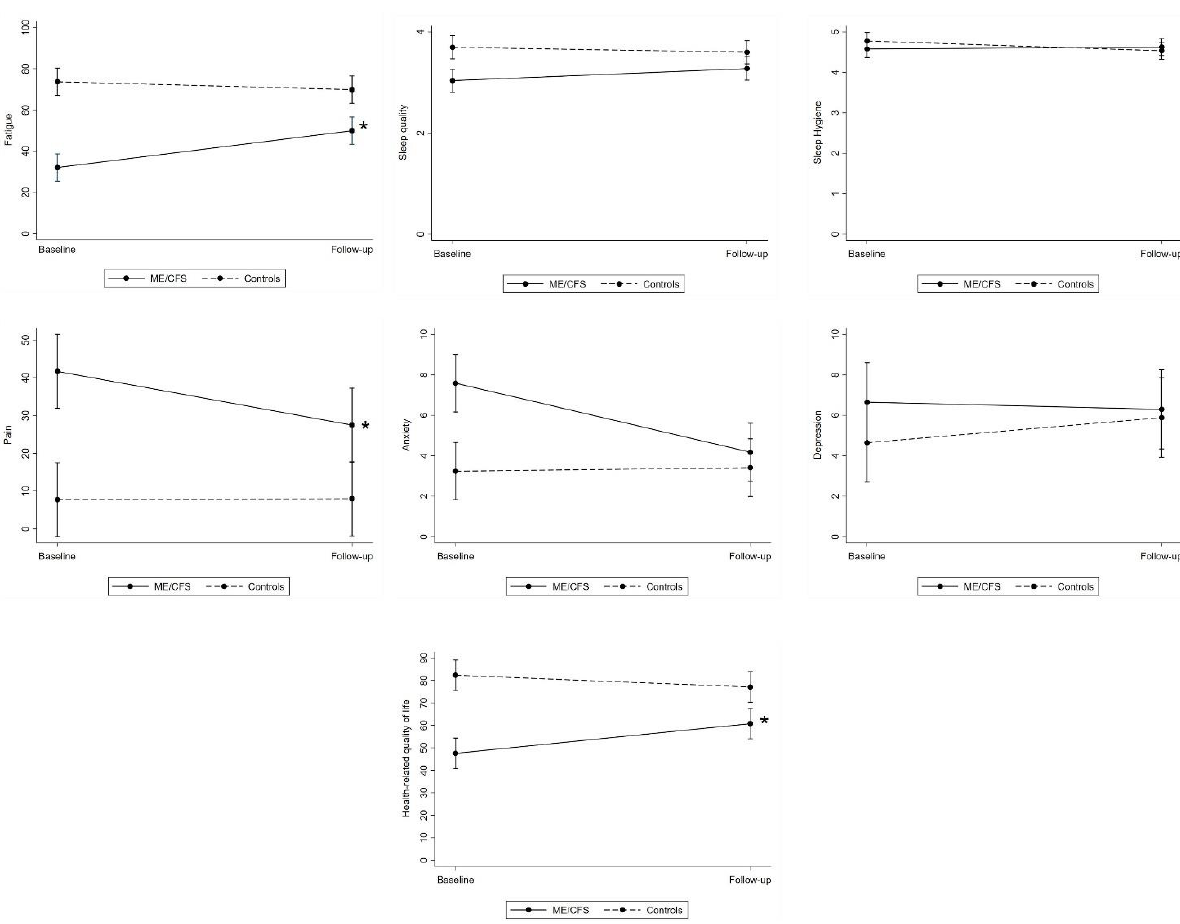
Figure 1. Estimated mean differences in measures of health and psychological wellbeing over time (baseline vs. follow-up) and between groups (ME/CFS vs controls). * Significant within-group change over time at 0.05 level and moderate to large Cohen’s d effect sizes ≥ 0.5.